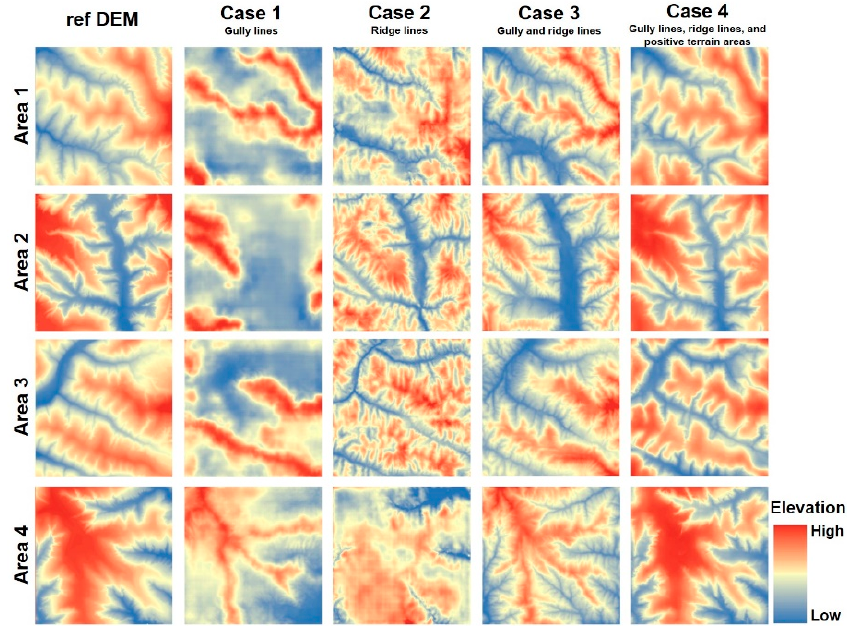
Figure 4. Results based on the different combinations of topographic features. Ref DEM represents the reference data.